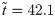
Test 3: Comparison between FOM and DL-ROM solutions for a testing-parameter instance at different time instances.FOM solution (left) and DL-ROM one (right), with n = 10, at t˜=42.1 ms (top) and t˜=276 ms (bottom), for the testing-parameter instance μtest = 12.9 ⋅ 0.1435 mm2/ms.